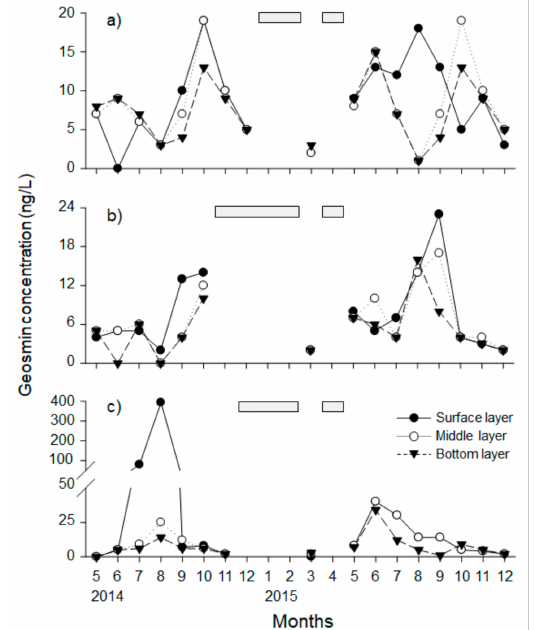
Figure 4. Temporal variation of geosmin at three different water depths in three lakes—( a ) Uiam, ( b ) Cheongpyeong, ( c ) Paldang lake—from May 2014 to December 2015. Gray bar indicates data loss/missing due to freezing conditions or missing